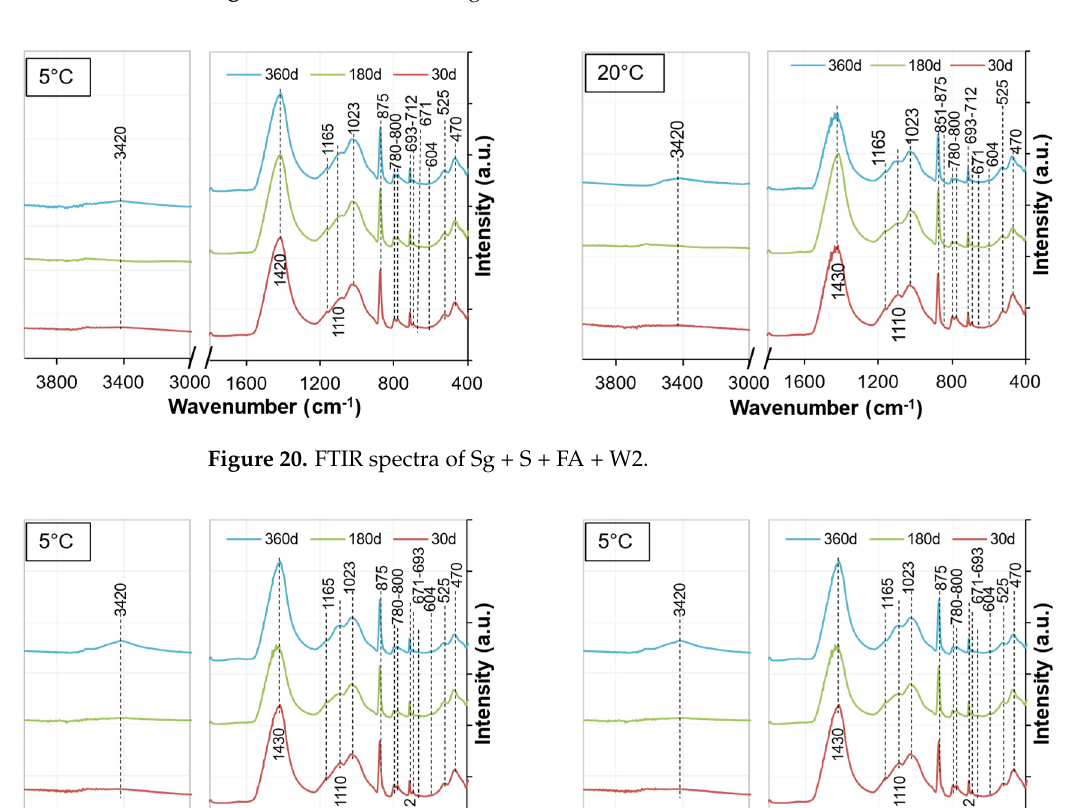
Figure 19. TGA traces of Sg + S + C + W2.